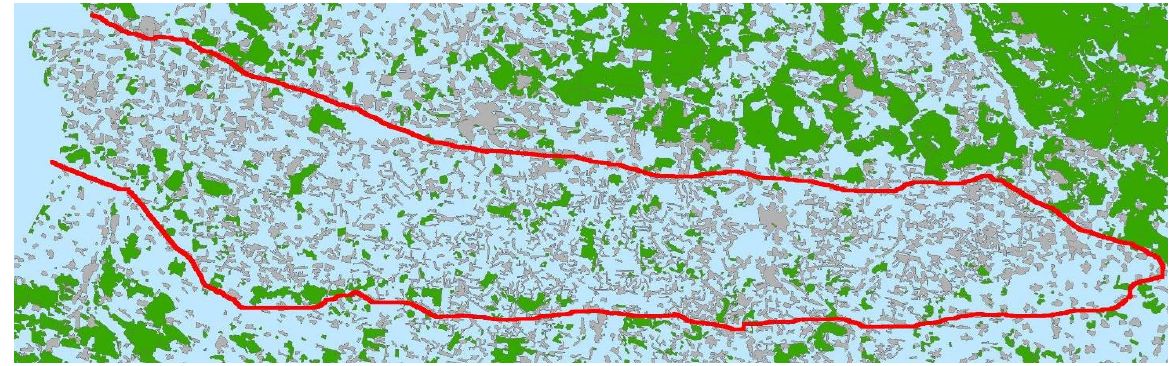
Fig. 2. Satellite map of the forests of the studied region (green colour – forests, red line – borders of the research